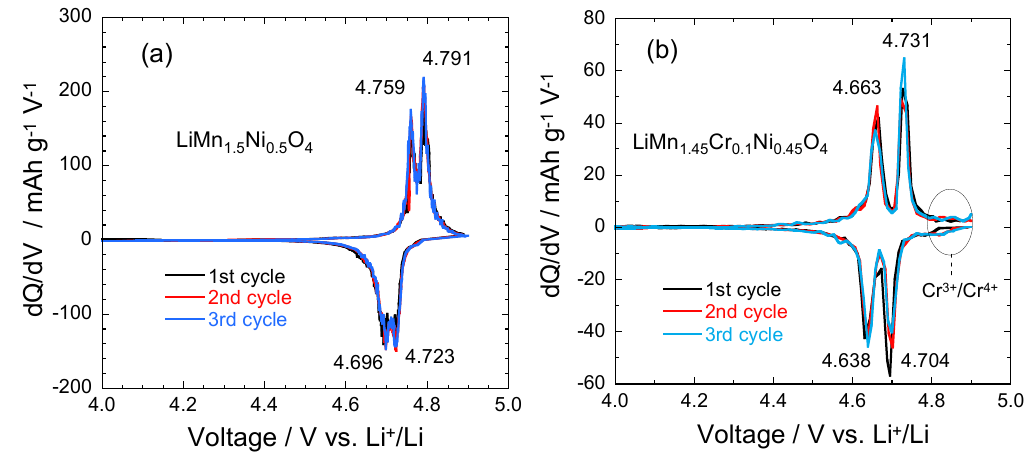
Figure 7. Differential capacity curves, d Q /d V vs. V , of the ( a ) LMN and ( b ) Cr-doped LMN. The values at the peaks are given in volt